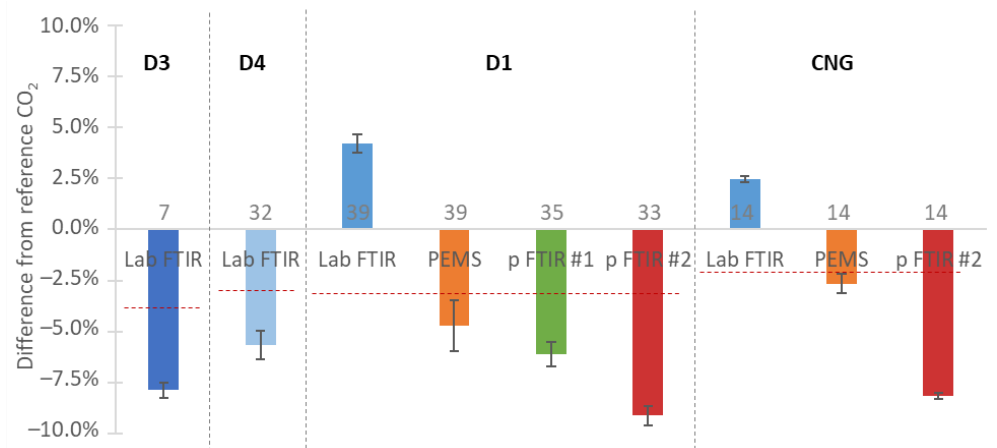
Figure 6. Comparisons of instruments measuring CO 2 vs. laboratory NDIR analyzers. Red dashed lines give the means of all the instrument measurements. Error bars are one standard deviation of the number of repetitions given on/in the bars. CNG = compressed natural gas engine; D = diesel engine; FTIR = Fourier transform infrared; p = portable; PEMS = portable emissions measurement system (with heated NDIR analyzer).